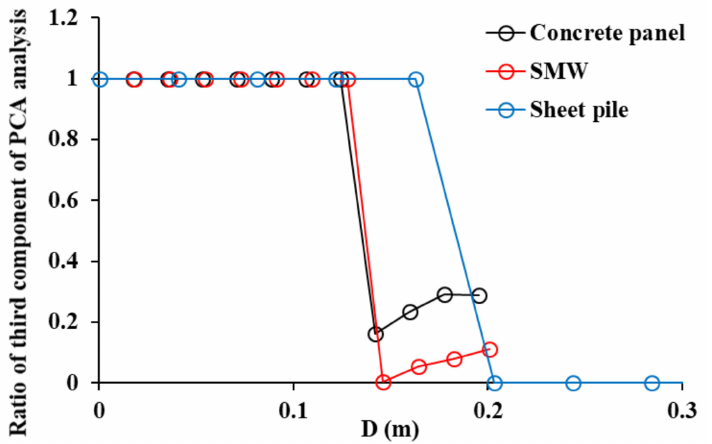
Figure 16. PCA analysis to define optimized D in